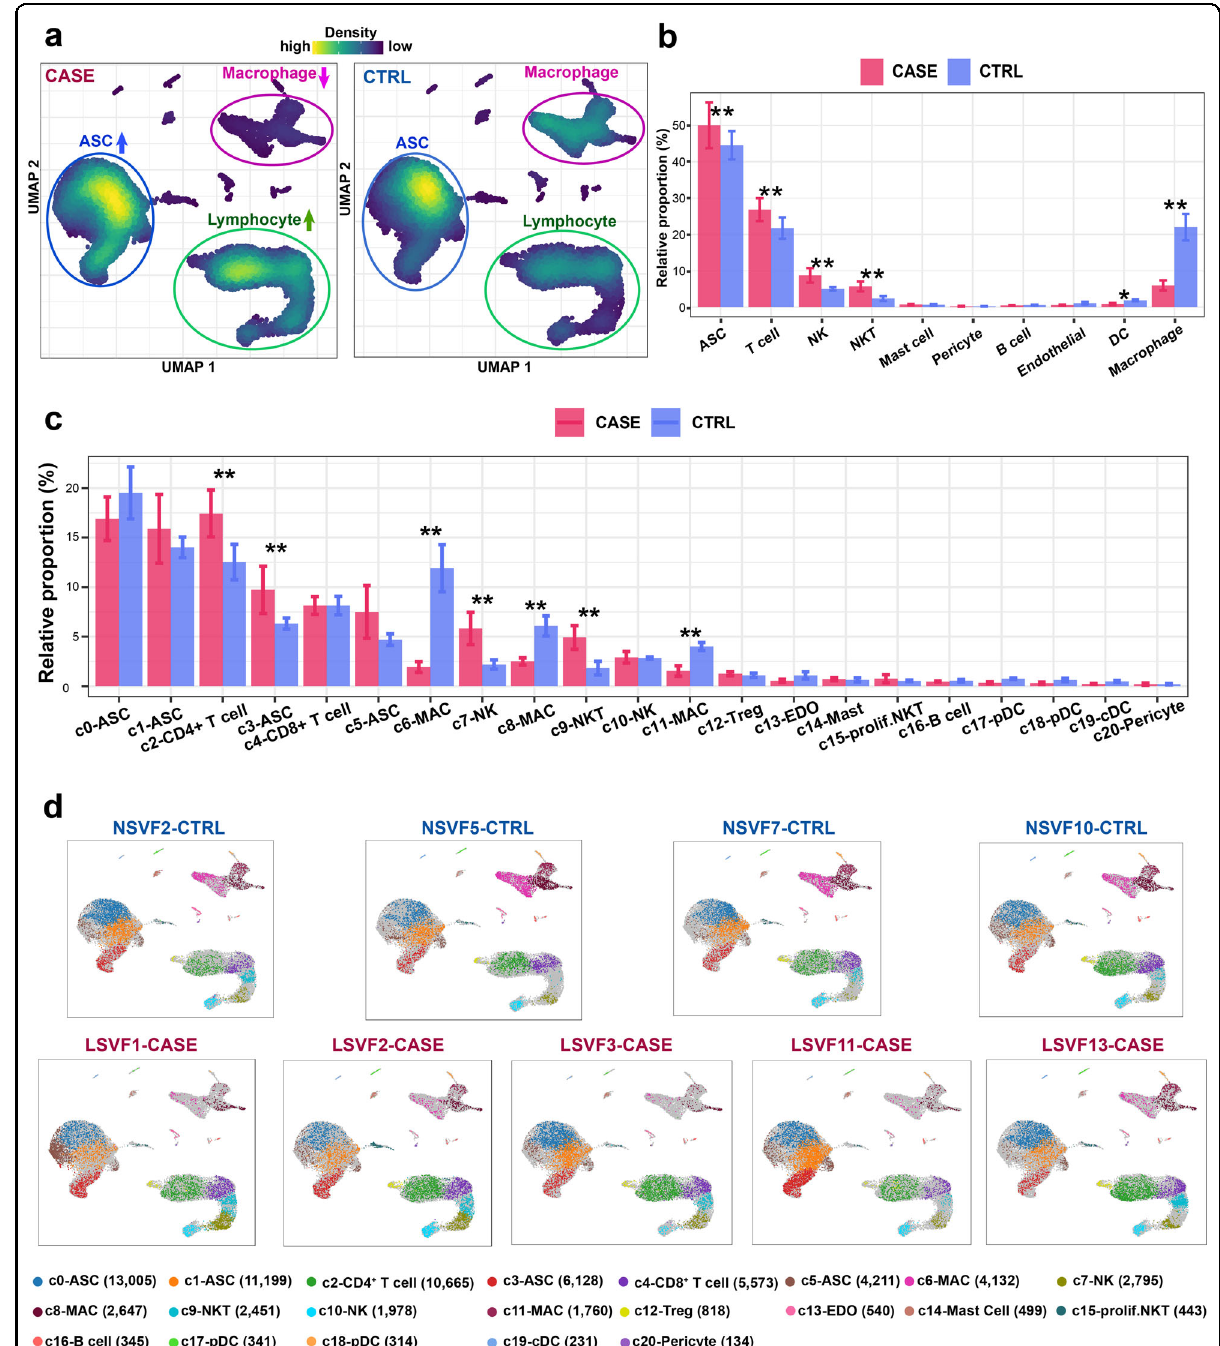
Fig. 2 Differential proportional analysis reveals signi fi cantly expanded or contracted cell lineages and subpopulations associated with cancer-related lymphedema. a Visualization of the cellular density reveals dramatic changes in the proportions of multiple cell lineages in CASE versus CTRL. An equal number of cells ( n = 28,935) were randomly sampled for each group. b Signi fi cantly expanded or contracted cell lineages. c Signi fi cantly expanded or contracted cellular clusters. d The distribution of cells for each cluster in each individual. In b and c , a permutation-based statistical test (differential proportion analysis) was performed. Data are represented as means ± SE. *Bonferroni-corrected P value < 0.05; **Bonferroni-corrected P value < 0.01. CASE, cancer-associated lymphedema; CTRL, healthy